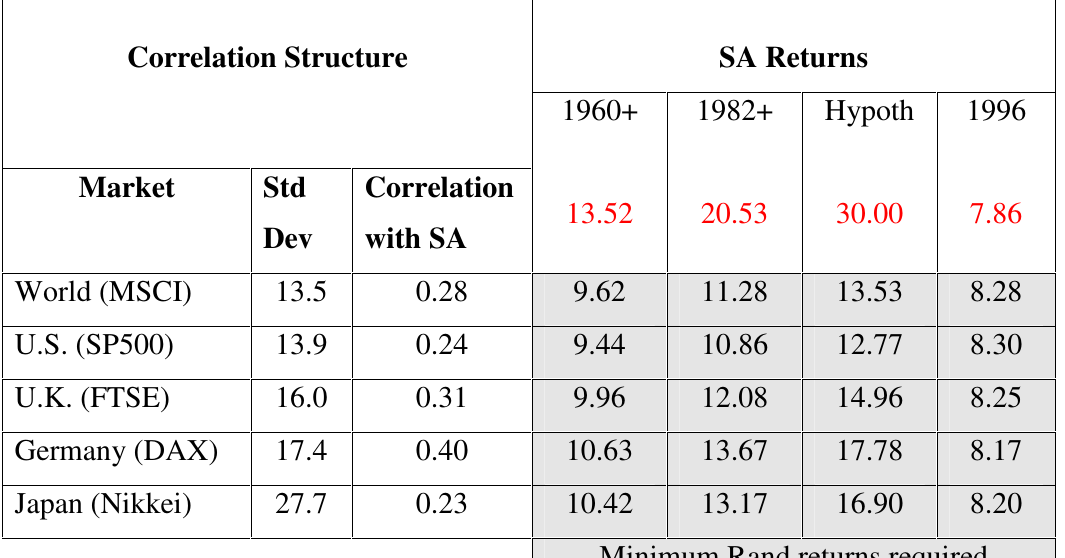
r in the foreign currency h